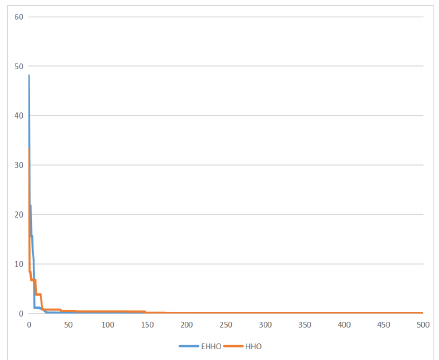
Figure 5. Rastrigin